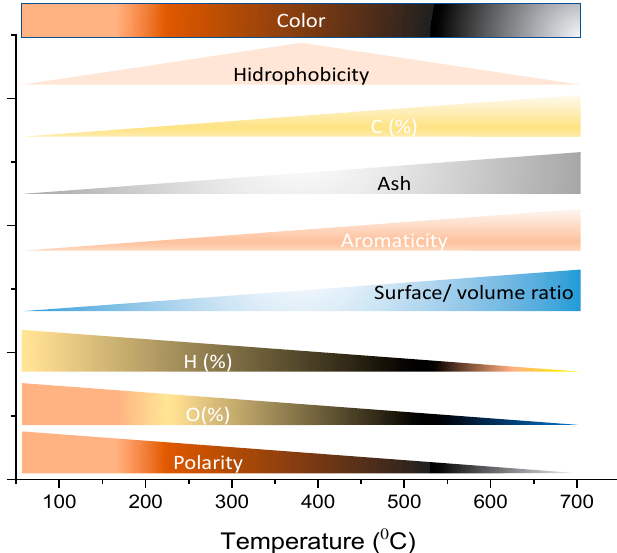
Figure 1. Variation in biochar properties with an increase in pyrolysis temperature conditions Adapted from Ref. [35].